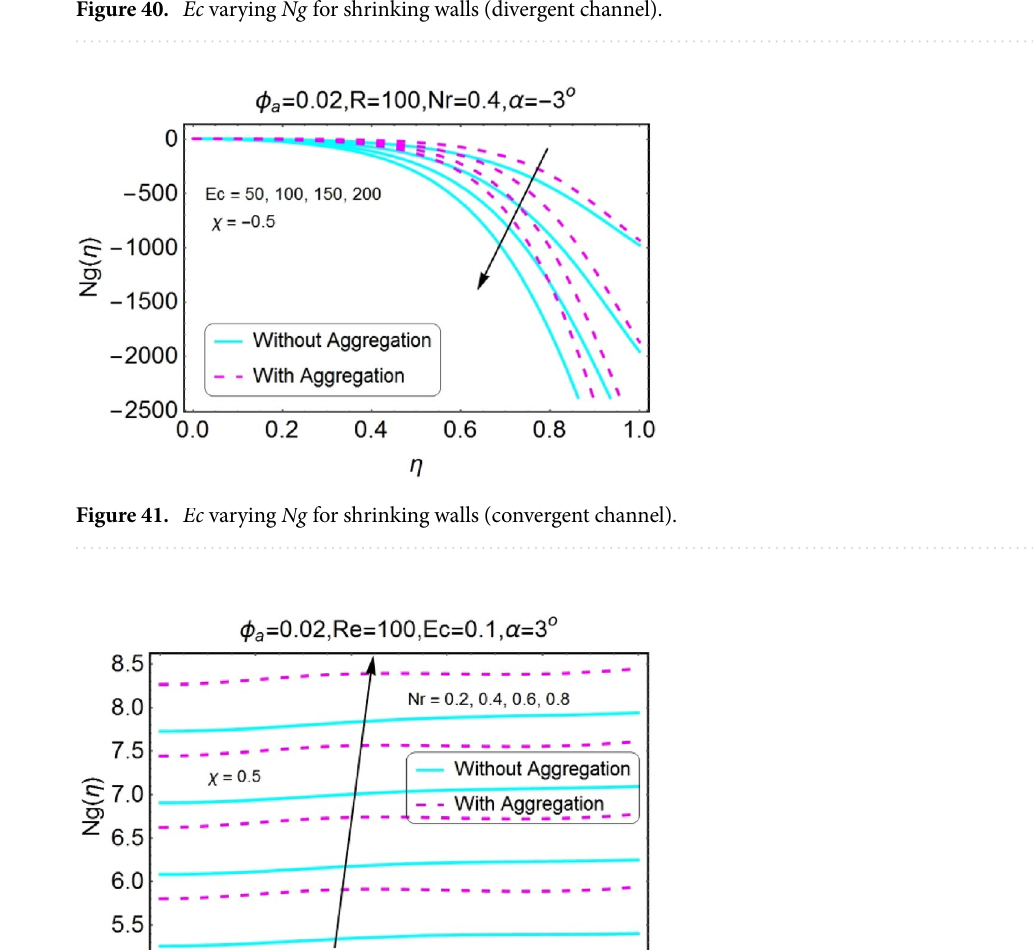
Figure 40. Ec varying Ng for shrinking walls (divergent channel).